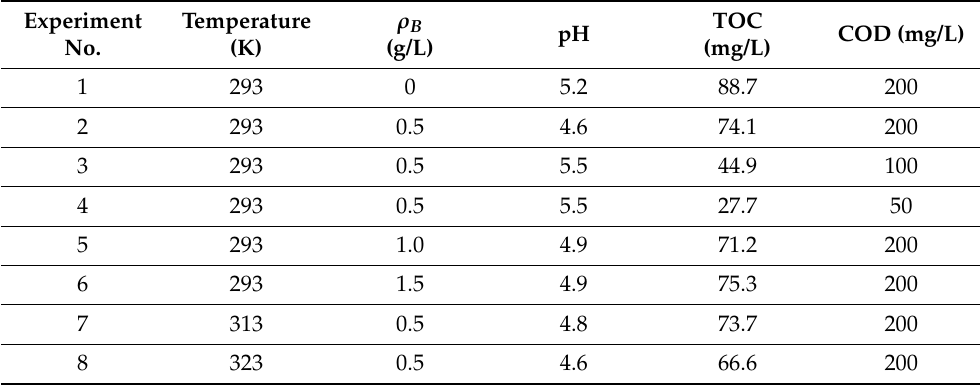
Table 1. Different conditions of temperature and catalyst dose used for the experiments at fixed values of Q air = 1.0 × 10 − 6 m 3 /s and v = 500